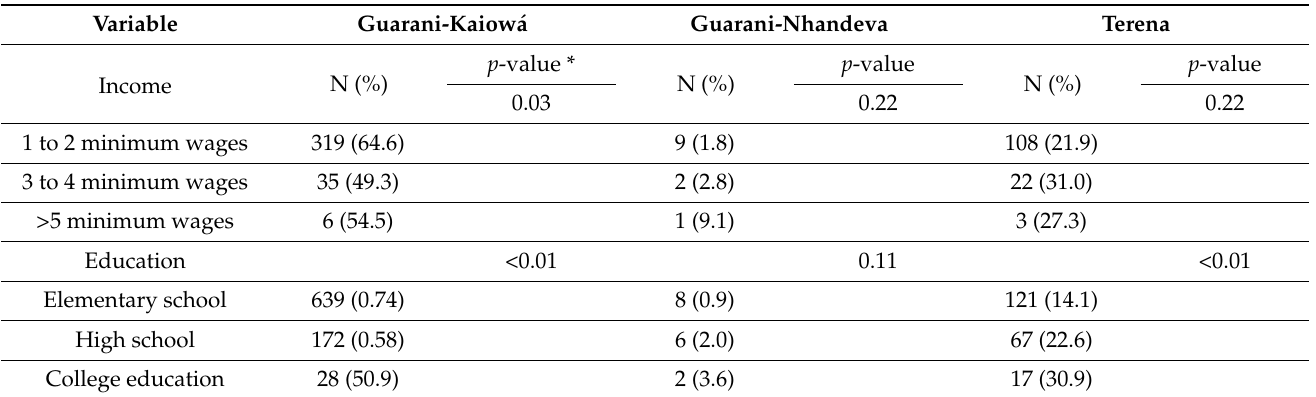
Table 3. Seroprevalences of HSV-2 (anti-HSV-2 IgM) in individuals exhibiting clinical symptoms in Indigenous community, Mato Grosso do Sul, Brazil.